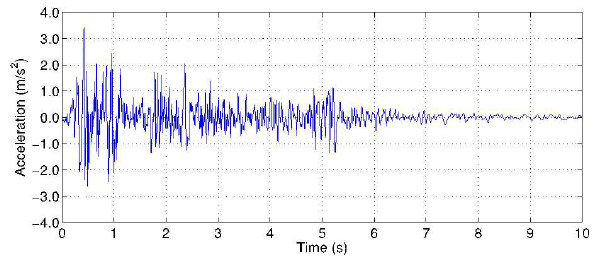
Figure 3: Time-scaled El-Centro NS earthquake ground motion (0.2